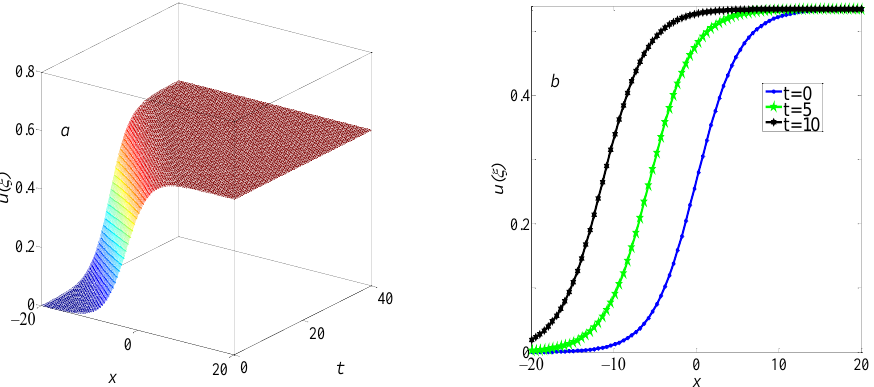
Figure 1. ( a ) Three-dimensional and ( b ) two-dimensional plots represent the kink solitary-wave solution of Equation (8) when 𝜂 = 1, 𝜀 = 1, 𝑟 = 1, and 𝑘 = −0.38 .